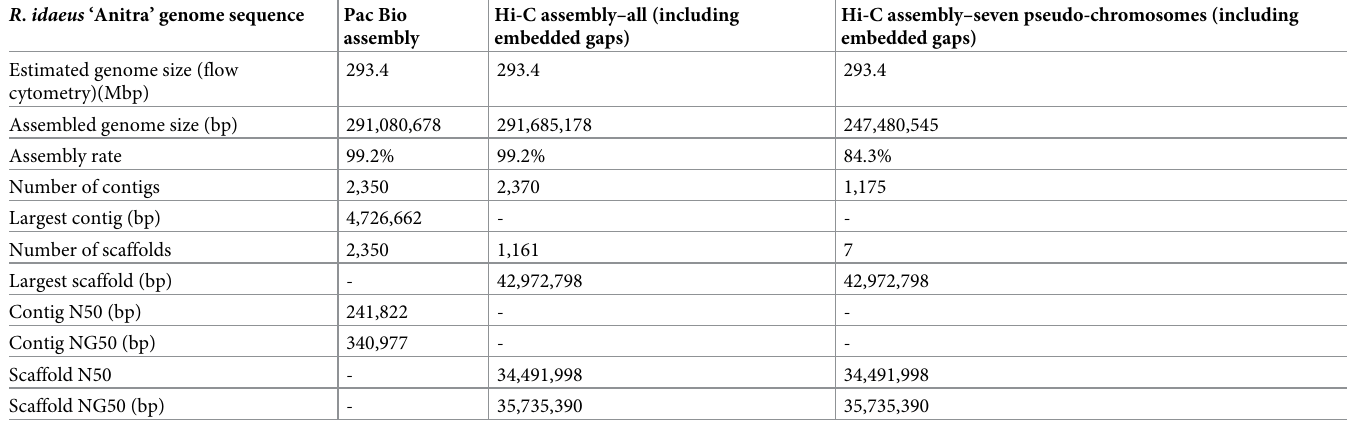
Hi-C assembly–all (including assembly embedded gaps)